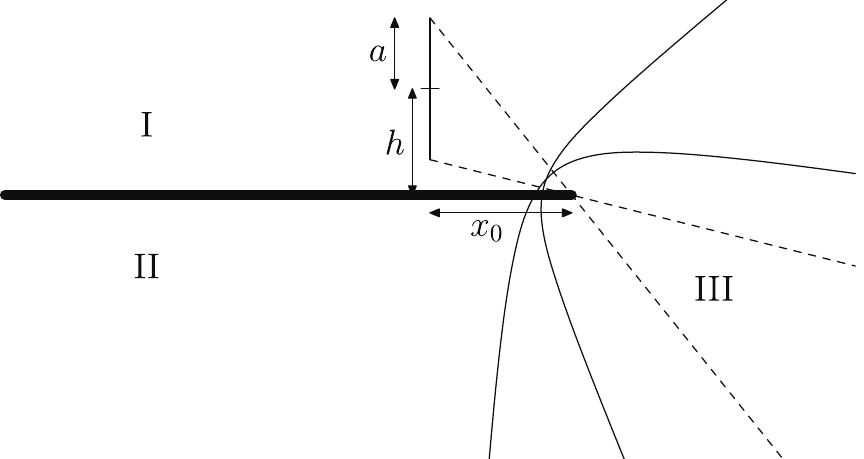
Figure 4. Regions around rotor labelled by far- fi eld approximation. The hyperbolae of (11) are shown for the top and bottom of the rotor with A = 10 and K ¼ 12 =